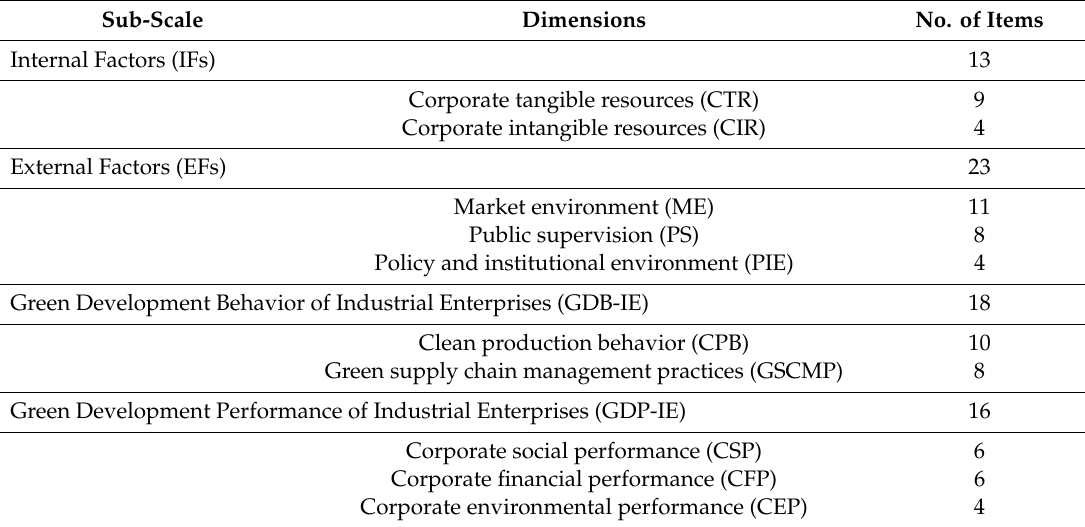
Table 1. Structure of the GDBP-IE